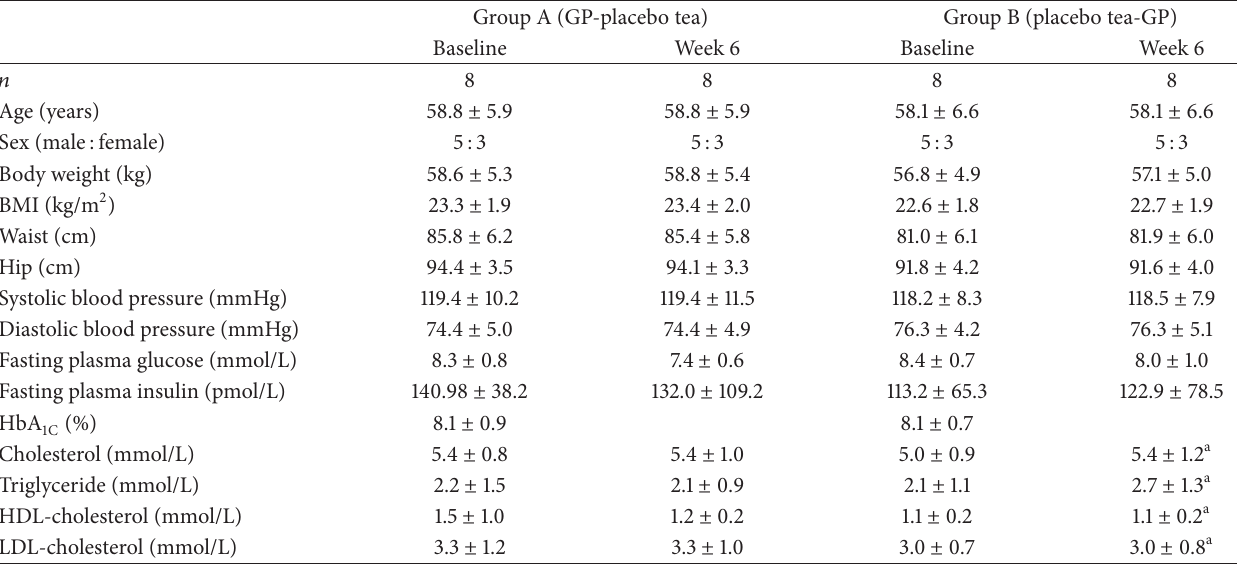
Table 1: Clinical characteristics and laboratory findings of the patients.